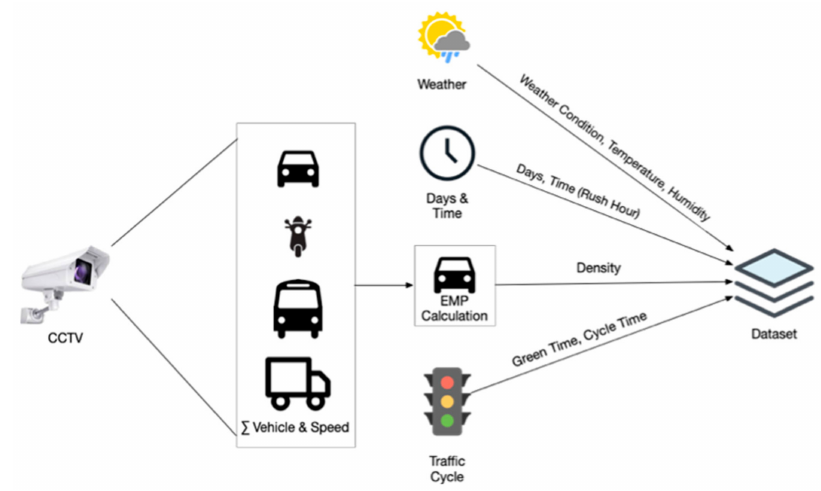
Figure 12. Traffic Dataset Compilation using Public